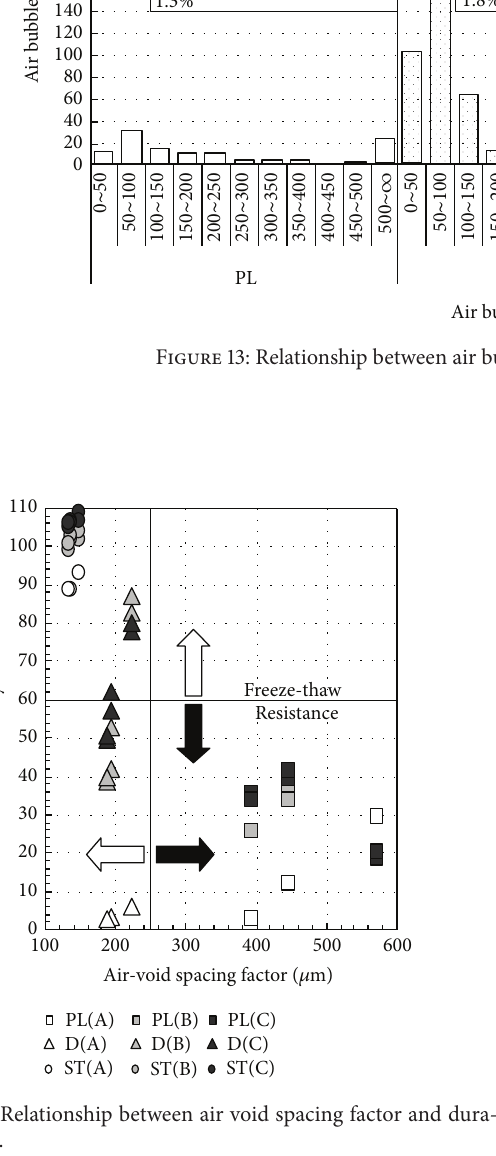
Figure 16: Interpretation of